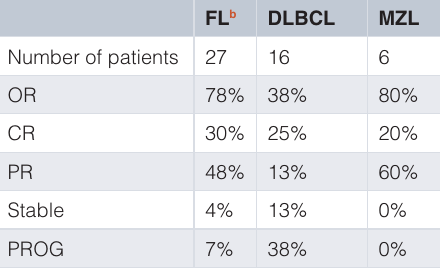
Table 2. Efficacy of bendamustine/rituximab/ venetoclax against NHL a